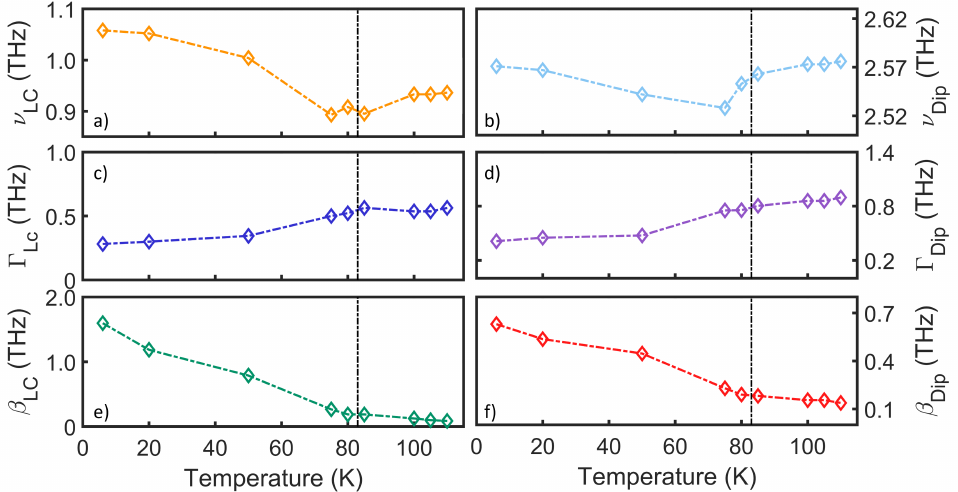
Figure 4. Fitting results (empty symbols) for the complementary SRR device vs. T, as obtained applying Equation (1) to data in Figure 2b. The dashed color lines are a guide for the eyes. Error bars correspond to the size of diamond symbols. Panels ( a , c , e ) show the resonance frequency ν LC , the line width Γ LC , and the coupling coefficient β LC of the LC resonance; ( b , d , f ) show the same quantities for the dipolar resonance. The black vertical point-dashed lines underline the YBCO critical temperature T c = 81